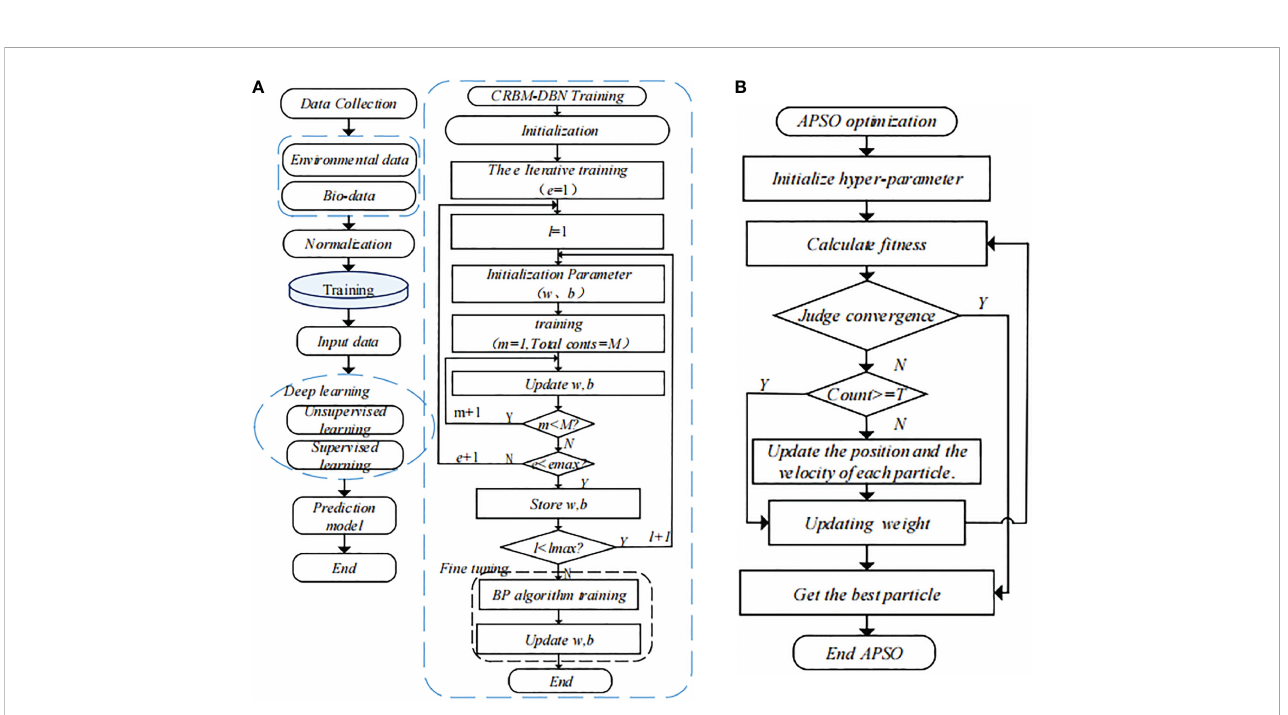
FIGURE 2 Training process of the APSO-CRBM-DBN disaster-induced biomass prediction model. (A) Predictive model training process. (B) APSO optimization